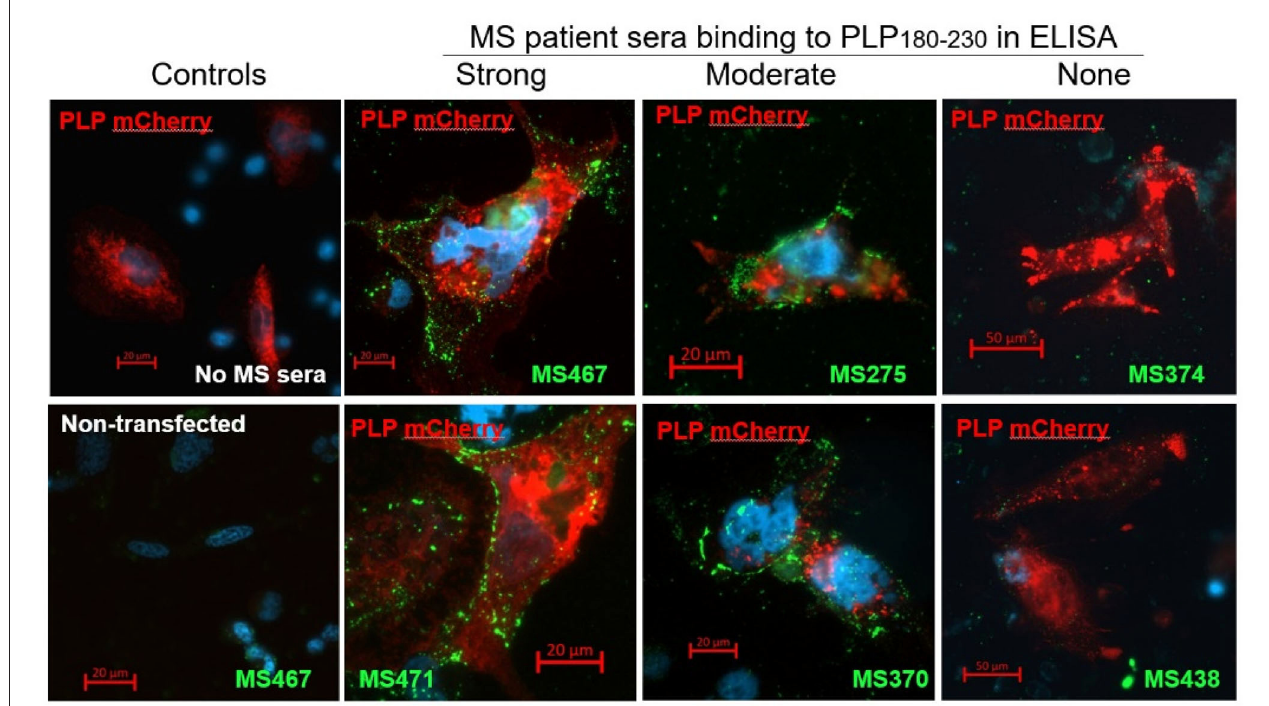
FIGURE 1 | CHO cells transiently transfected with an mCherry-PLP construct (so that cells expressing PLP fluoresce red) were live-labeled using MS patient sera that showed high (MS467 and MS471), moderate (MS275 and MS370) or no (MS374 and MS438) binding to the PLP 181 − 230 peptide in ELISA assays. Binding of patient sera to the transfected CHO cells was revealed by addition of a FITC-labeled anti-human Ig secondary antibody (green). Controls included wells with no MS sera added (top left image) and non-transfected cells in the wells to which MS sera were added (bottom left image showing non-transfected cells in the well in which MS467 serum was added). MS sera that showed high or moderate binding to the PLP 181 − 230 peptide in ELISA assays labeled the membranes of PLP-transfected CHO, whereas sera that showed no anti-PLP 181 − 230 binding by ELISA did not label the PLP-transfected CHO cells.